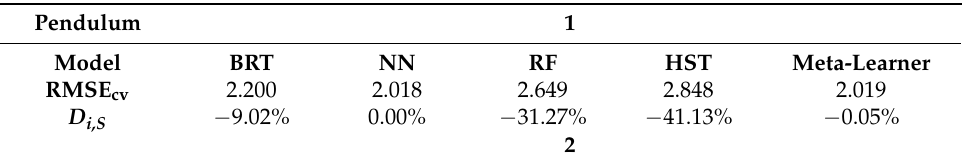
Table 6. Results of experts and meta-learners trained through Stacking strategy and Blocked CV. D